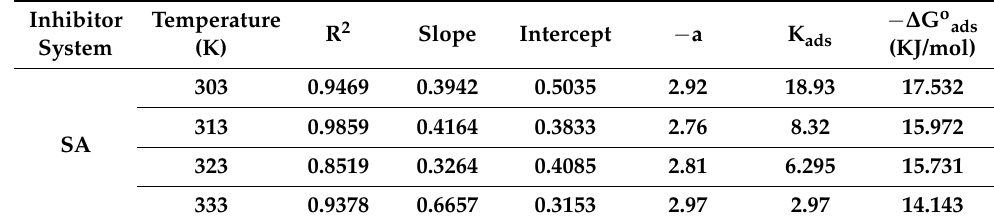
Table 6. Adsorption parameters obtained from Temkin adsorption isotherm for corrosion inhibition effect of aqueous leaf extract of SA on mild steel in 1.0 M HCl.